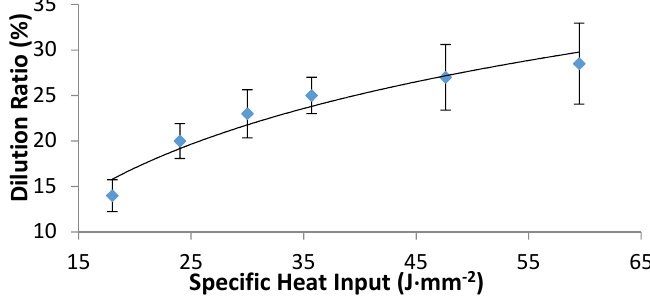
Figure 14. Dilution ratio versus the specific heat input.